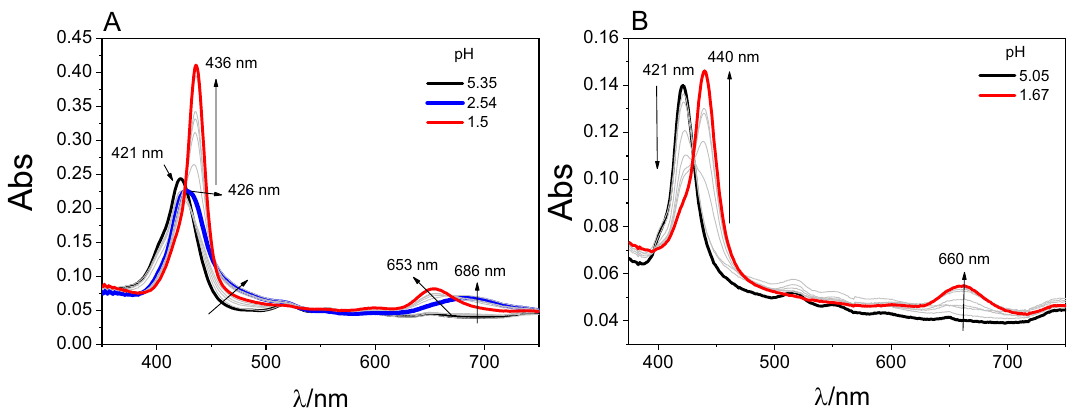
Figure 5. Absorption spectra recorded during the addition of 1 M HCl to a solution of: ( A ) TPPNH 2 and ( B ) GO-CONHTPP in DMF-H 2 O (1:2,